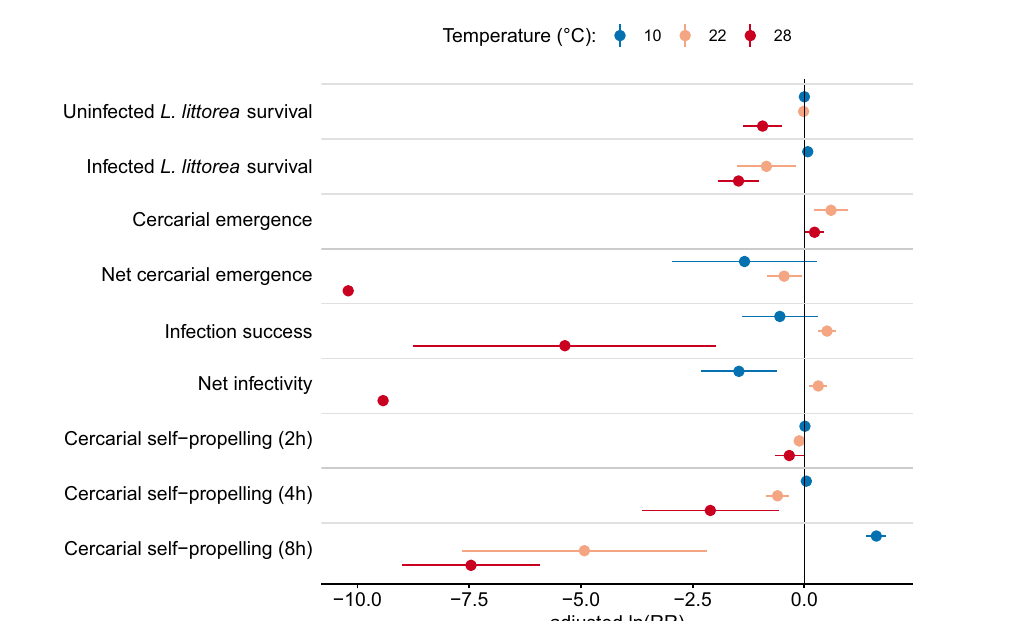
Figure 5. General additive mixed model of Himasthla elongata cercarial acute infection success ( A ) and generalized linear mixed model of cercarial net infectivity ( B ) after 24 h of exposure to Mytilus edulis s.l. under different temperatures with gaussian ( A ) and zero-inflated negative binomial ( B ) distributions. The blue dot represents the optimal temperature [21.5 °C ( A ) and 19.8 °C ( B )] for cercariae infectivity [45% infectivity ( A ) and 1933 infective cercariae from surviving snails ( B )].